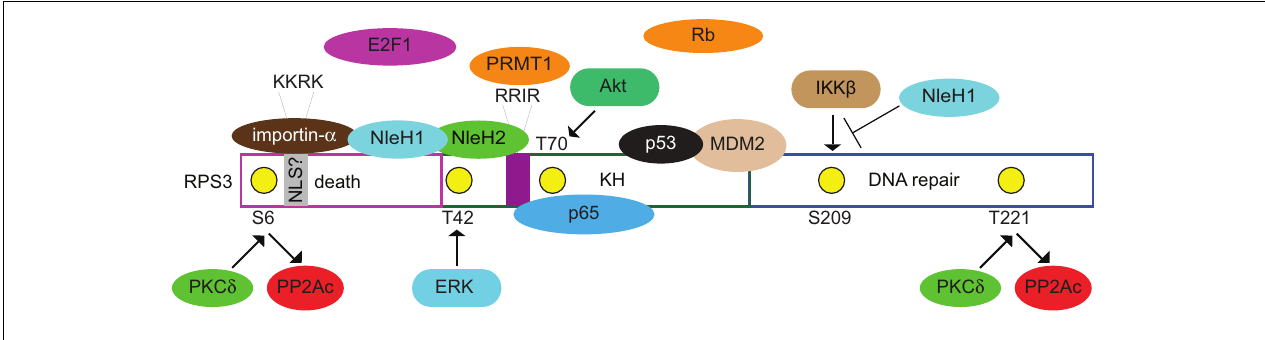
inhibits the IKK β -mediated phosphorylation of RSP3 S209. Figure is not drawn to scale and specific protein–protein interactions and/or binding interfaces should not be inferred, except where specifically indicated in the